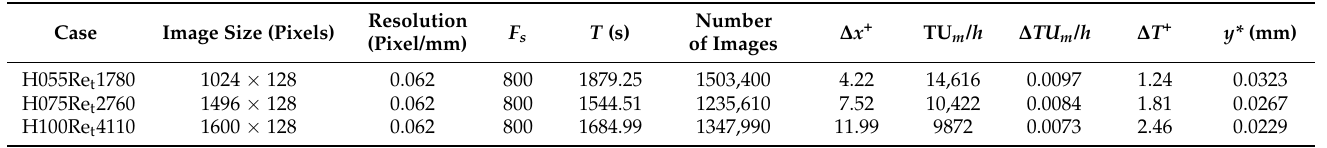
Table 2. PIV parameters for each flow case (a)